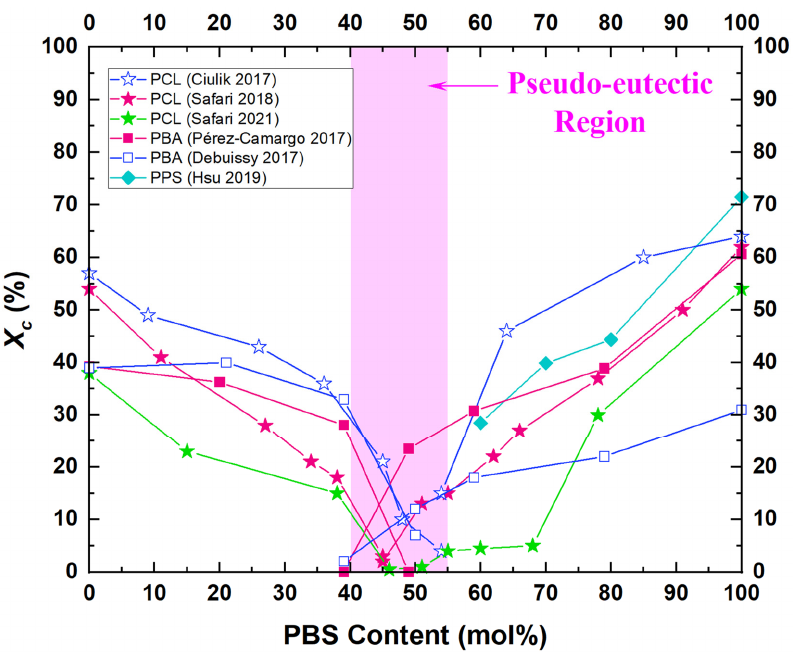
Figure 4. Variation of the degree of crystallinity as a function of the PBS composition for selected copolyesters. Pseudo-eutectic points can be observed in the shaded region.